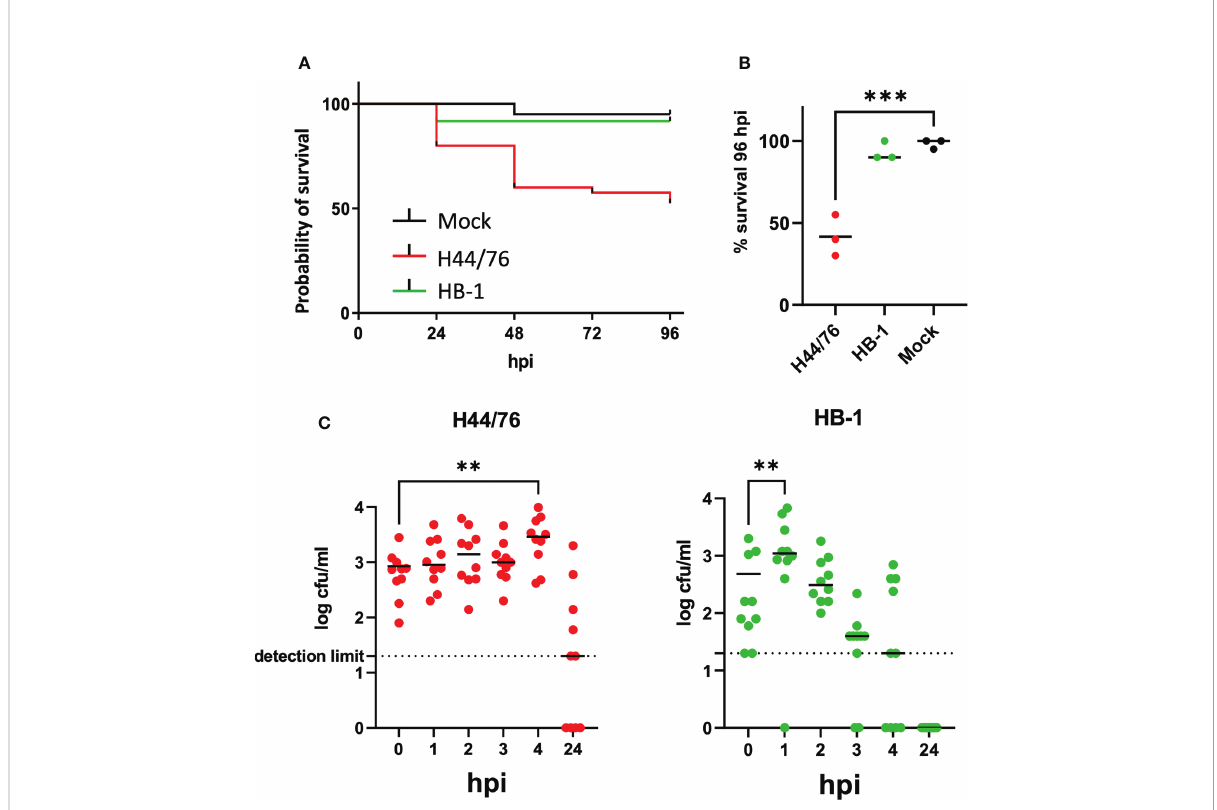
FIGURE 3 (A) Survival curve of zebra fi sh embryos infected with capsulated H44/76 (9600 cfu) or non-encapsulated meningococci HB-1 (5200 cfu); 20 embryos in each group. (B) Survival scored at 96 hpi (right panel). Zebra fi sh embryos were infected with mCherry-expressing H44/76_B (2700 ± 1820 cfu), HB-1 (1960 ± 1420 cfu) or mock-infected. Three independent experiments each with 20 embryos in each group. (C) . Survival and multiplication of meningococci (H44/76_B) or non-encapsulated meningococci (HB-1) in zebra fi sh embryos. Zebra fi sh embryos were infected with mCherry expressing H44/76_B (3000 cfu) or HB-1 (2800 cfu); 10 embryos in each group. ** P = < 0.01, ***: P = <